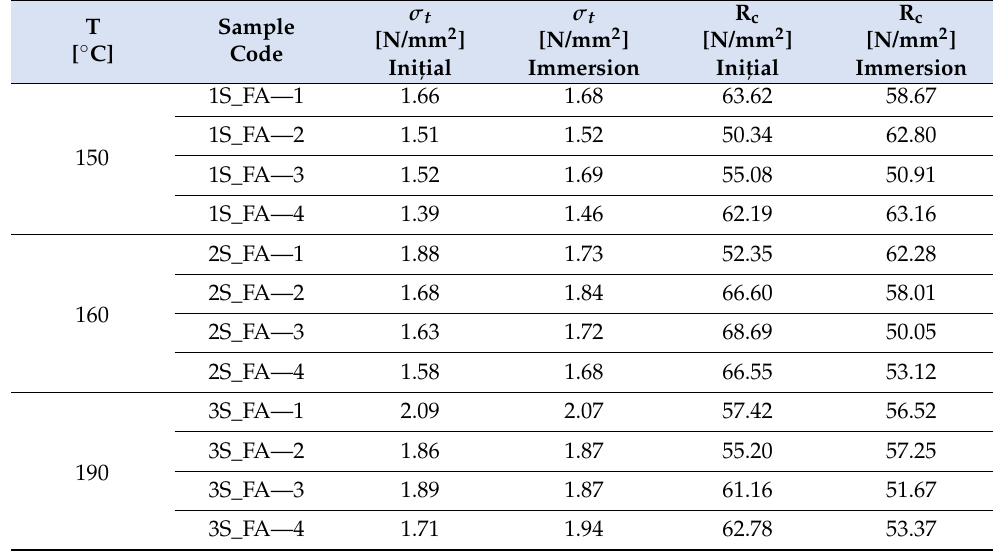
Table 2. Mechanical properties of composites with PET, rubber, HDPE, wood, and ash addition, before and after the water immersion.